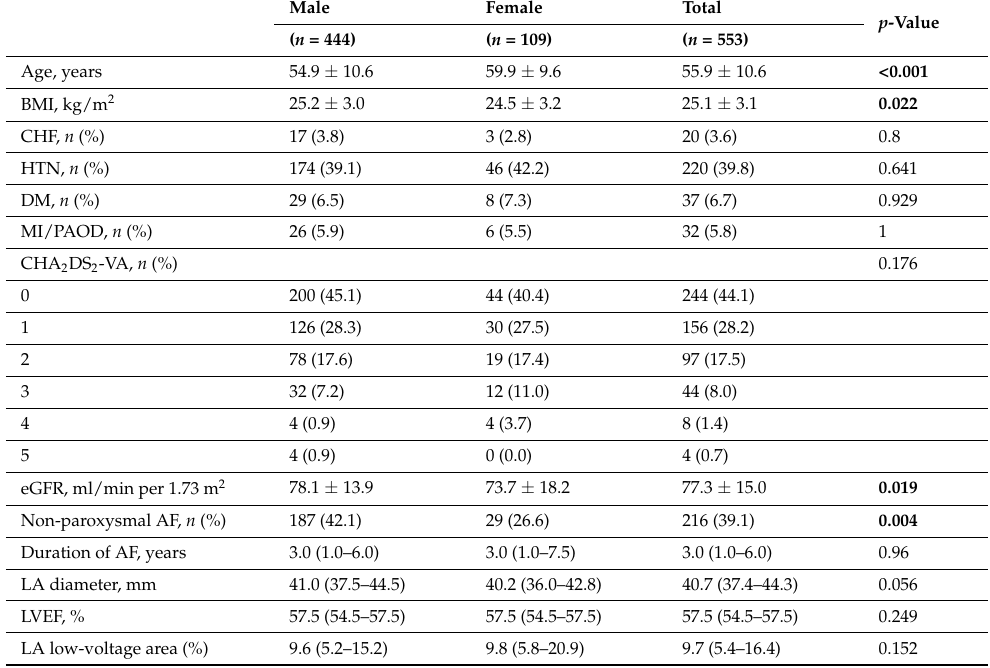
Table 1. Baseline